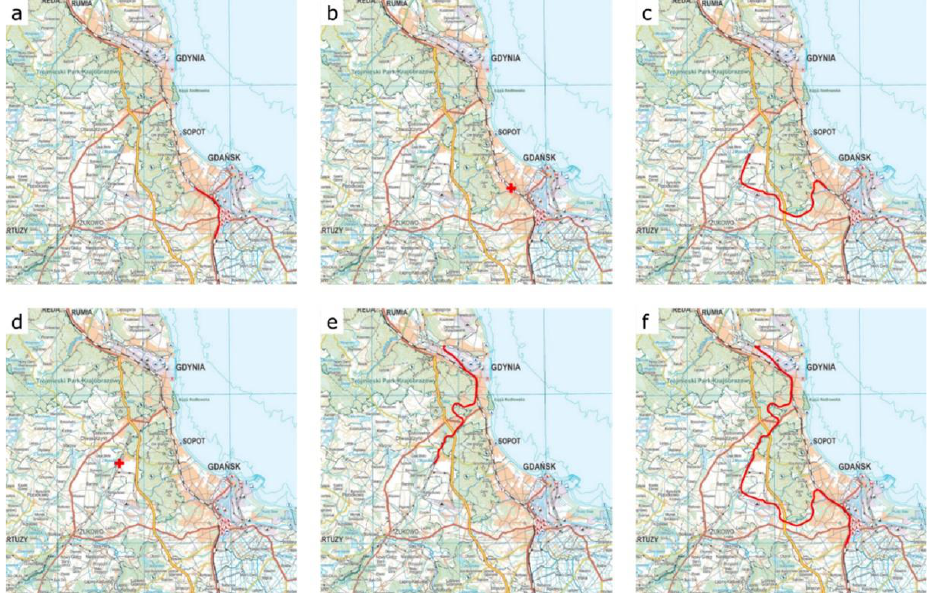
Figure 5. Sections of the GNSS/INS data recording in the kinematic mode: Gdańsk Południe - Gdańsk Wrzeszcz ( a ), Gdańsk Wrzeszcz - Gdańsk Osowa ( c ), Gdańsk Osowa -Gdynia Chylonia ( e ) and Gdynia Chylonia- Gdańsk Południe ( f ), as well as in the stationary mode: Gdańsk Wrzeszcz ( b ) and Gdańsk Osowa ( d ).